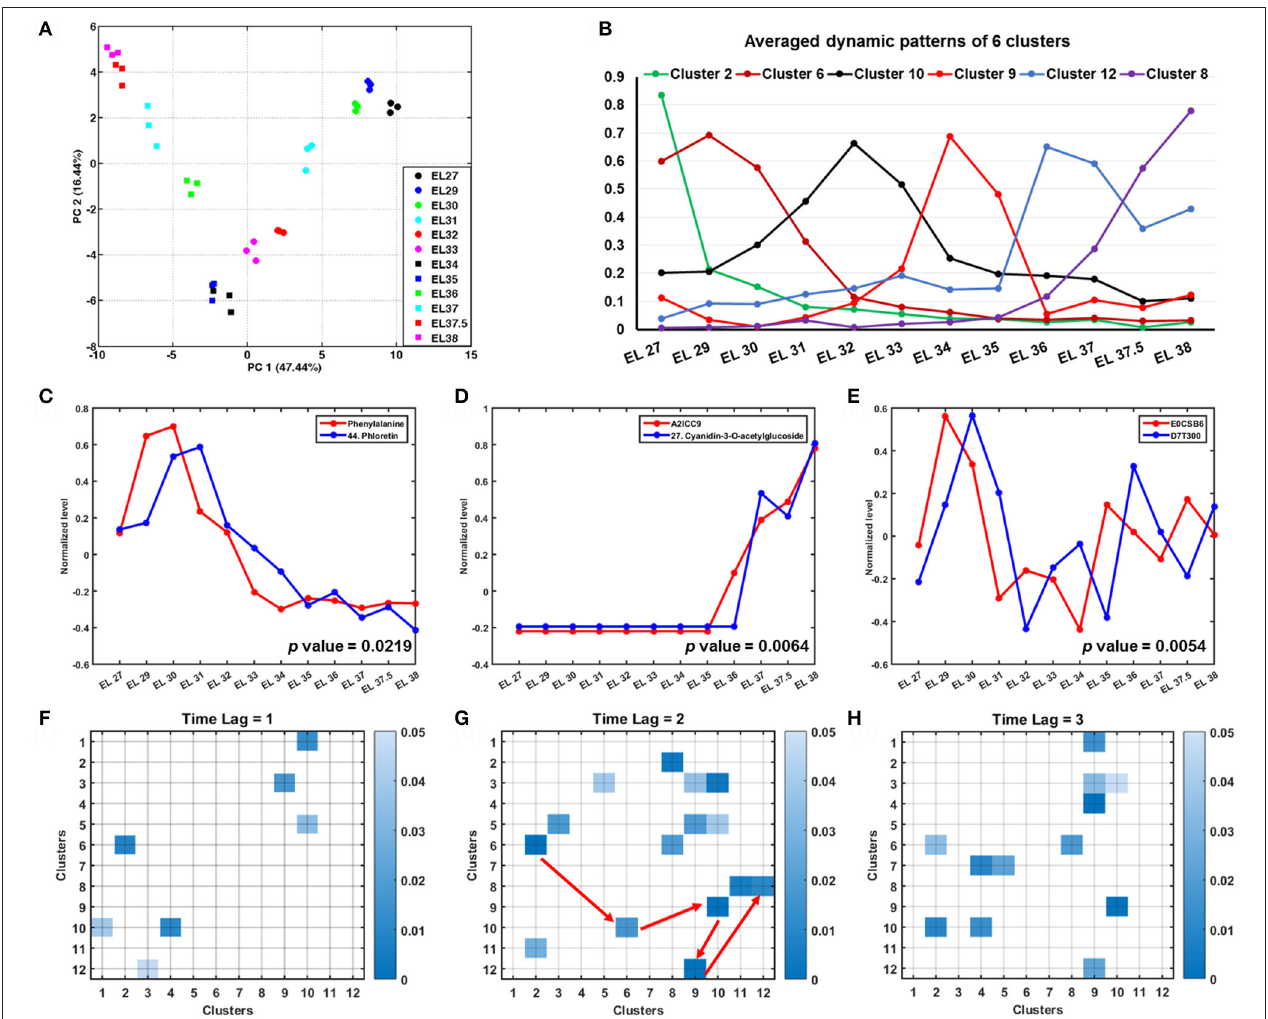
FIGURE 4 | Multivariate statistical and Granger causality analysis of integrated metabolome and proteome data during grape berry development. (A) PCA plot of the integrated dataset shows a trajectory during grape berry development. (B) The averaged dynamic patterns of 6 clusters from k-means clustering analysis. (C–E) Examples of Granger causalities showed directed interactions of metabolite-metabolite, metabolite-protein and protein-protein. (F–H) Present Granger causalities between clusters that resulted from k-means clustering analysis with time lag set as 1, 2, and 3,